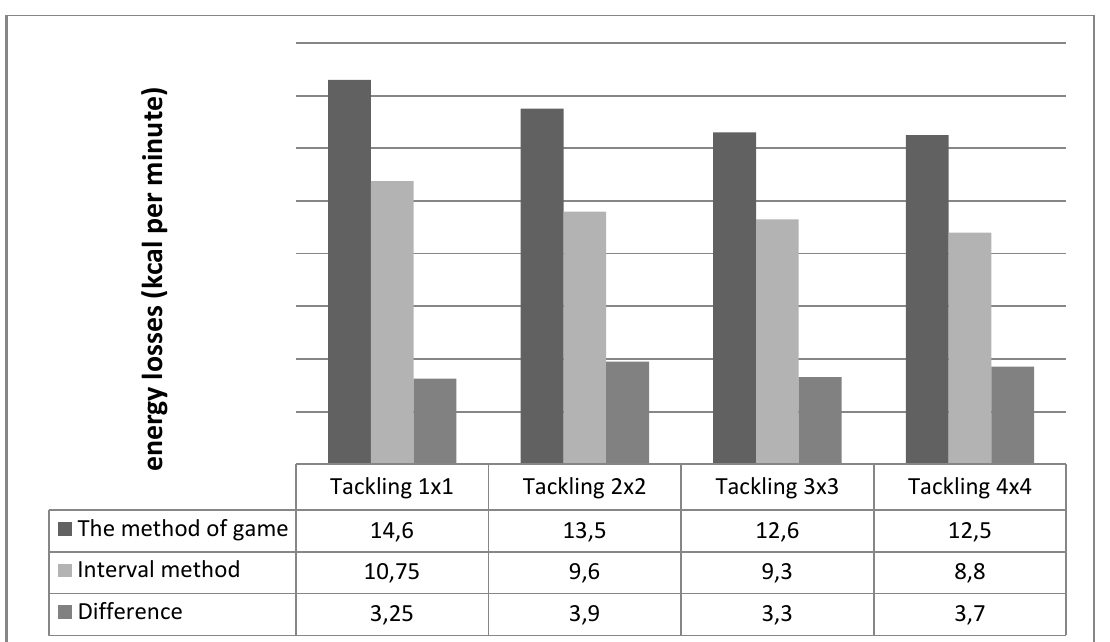
Fig.2. Dynamic of energy consumption with fulfillment of tackling by different methods